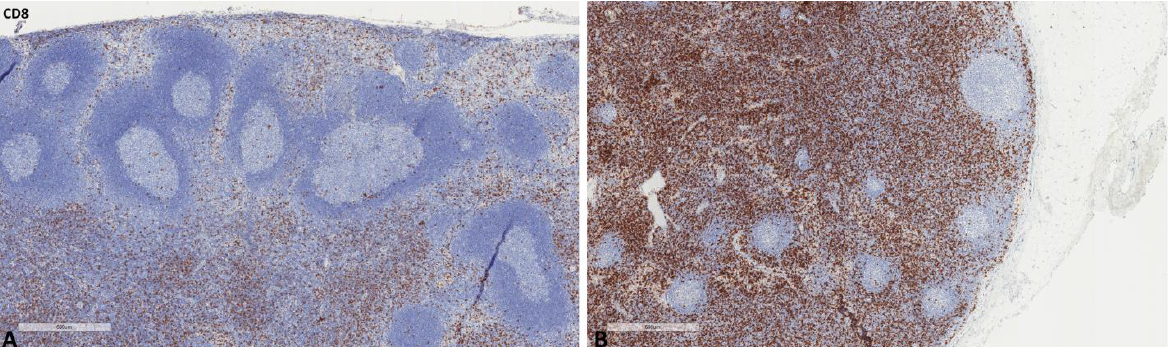
(6.293 ± 6.842 vs. 2.682 ± 3.920, p = 0.0206) and lower CD8 values (10.341 ± 7.614 vs. 25 ± 11.019 p < 0.0001), compared to vulvar cancer-draining nodes. Endometrial cancer- draining nodes had also lower CD8 values (10.341 ± 7.614 vs. 25.778 ± 17.042, p = 0.006), compared to cervical cancer-draining nodes. Tenascin-C was also higher in vulvar cancer- draining nodes (8.318 ± 10.816), compared to endometrial (2.463 ± 3.88) or cervical (0.889 ± 1.269) cancer-draining lymph nodes ( p = 0.0007 and 0.037, respectively). For distant nodes, the only statistically significant difference regarding primaries was the CD8 values, which were higher for the cervical, compared to the endometrial primaries (23.235 ± 13.572 vs. 9.417 ± 7.621, p = 0.01). Regarding low- and high-grade endometrial 10.154 ± 6.543, p = 0.0001) and CD163 (5.136 ± 6.198 vs. 9.077 ± 8.46, p = 0.0505) values. Figure 1. Representative microscopic images of S100A8/A9 expression in a normal cancer-draining lymph node ( A ) and a normal non-cancer-draining lymph node ( B ).